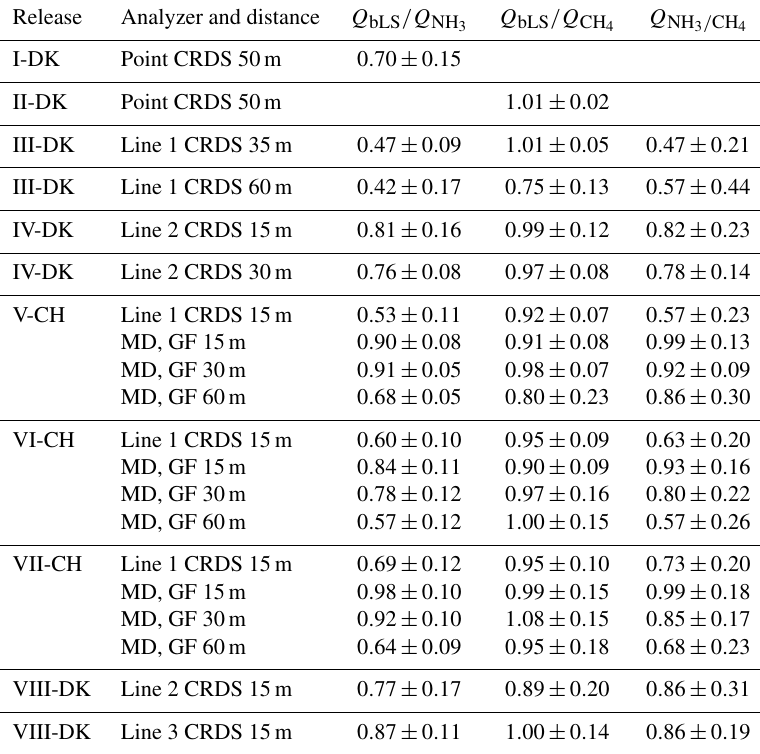
Table 2. Average of the recovery fractions Q bLS /Q of ammonia and methane for each release and analyzer with standard deviation. Lines 1 to 3 are described in the Fig. 2